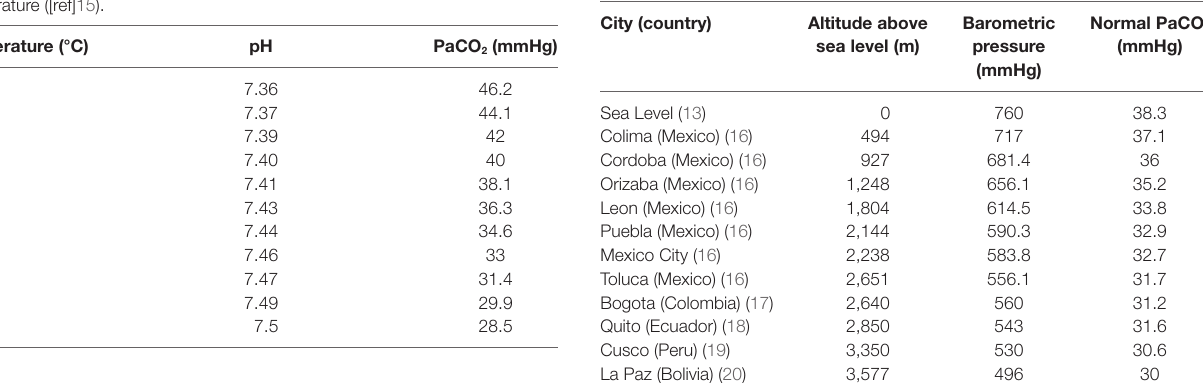
TABLe 2 | The normal PaCO 2 according to altitude and barometric